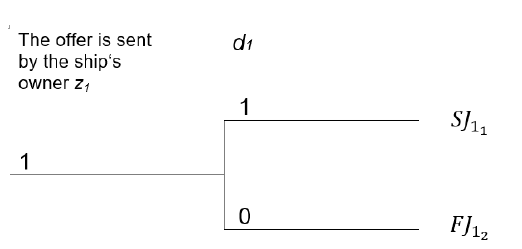
Figure 9. Event tree for activity d 1 .